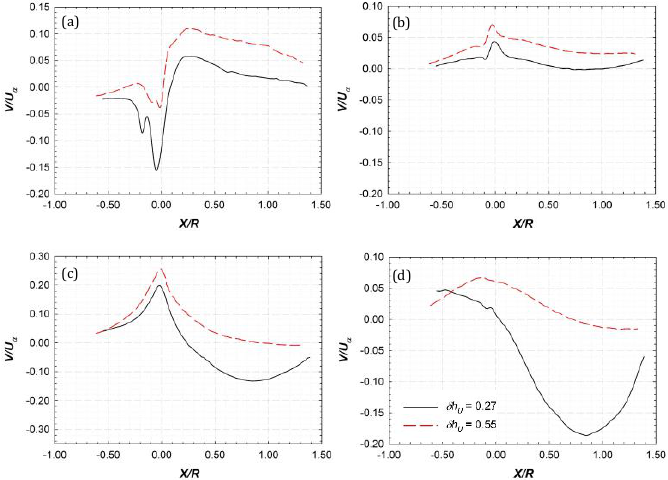
Figure 10. Variation of normalized vertical velocities in the upper-wake bypass region for the rotational velocity of 270 RPM and tip clearance ratios of 0.55 and 0.27 on horizontal lines at various depths: ( a ) Y/ R = 0, ( b ) Y/ R = 0.5, ( c ) Y/ R = 1, and ( d ) Y/ R = 1.3.